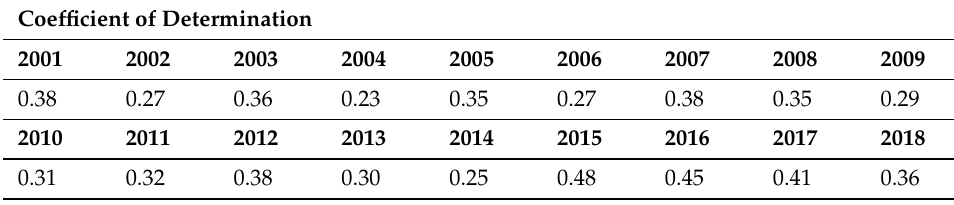
Table A3. Coefficients of determination for the years 2001 to